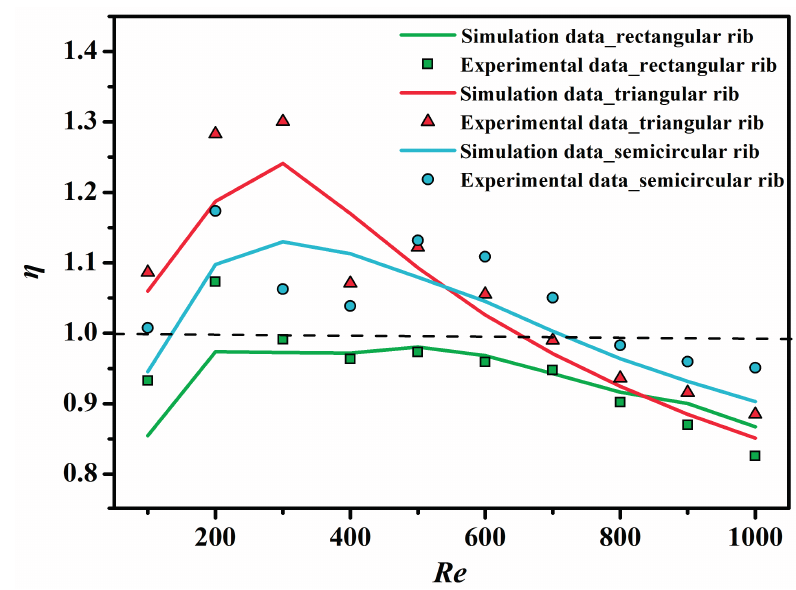
Figure 11. The thermal enhancement factor as a function of the Reynolds number for all ribbed